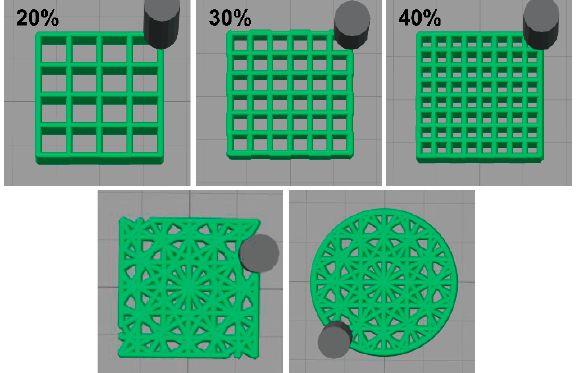
Figure 3. A series of 3D scaffolding slice models with different infill rate and infill patterns were prepared with Simplify3D software.